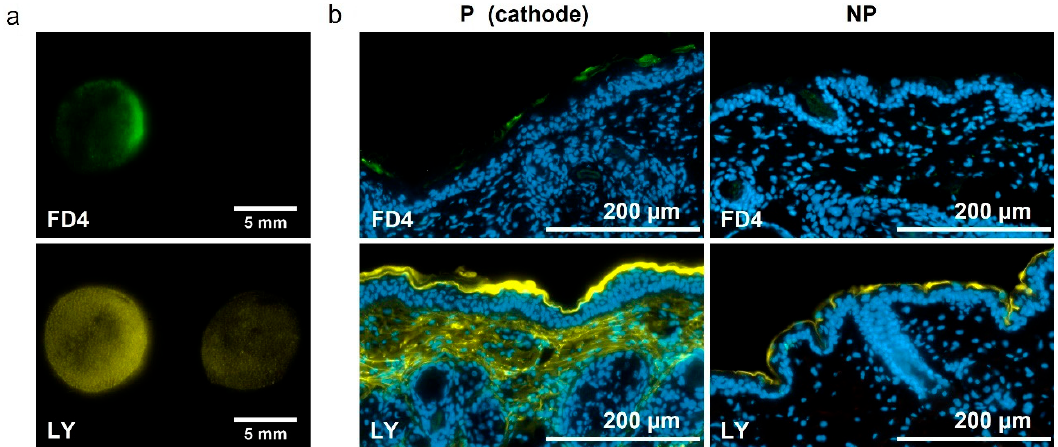
Figure 2. Evaluation of the skin permeabilization reversibility using the two-in-one nanocomposite device for EP. Platforms loaded with buffer only were used to apply unipolar EP treatment on hairless mice skin explants. One hundred microliters of LY (1 mM) were applied 0, 5, 15, 30 and 60 min after EP treatment, and left for 1 h at 37 ◦ C to assess the evolution of skin permeability through time. ( a ) Delivery pattern of LY applied at 0, 5, 15, 30 and 60 min after treatment with unipolar-pulsed electric field, compared to non-pulsed (NP) skin, platforms loaded with buffer. Cathode side was always on the left. ( b ) Quantification of LY RFI at the cathode and anode side of treated skin, depending on the time waited before LY application, compared to the LY RFI of non-pulsed skin. Statistical analysis: one-way ANOVA, Dunnett post-test vs. NP data. (Codes signification: * = p > 0.05; ** = p > 0.01; *** = p > 0.001; ns = non-significant). Error bars indicate SEM. n = 3–4.